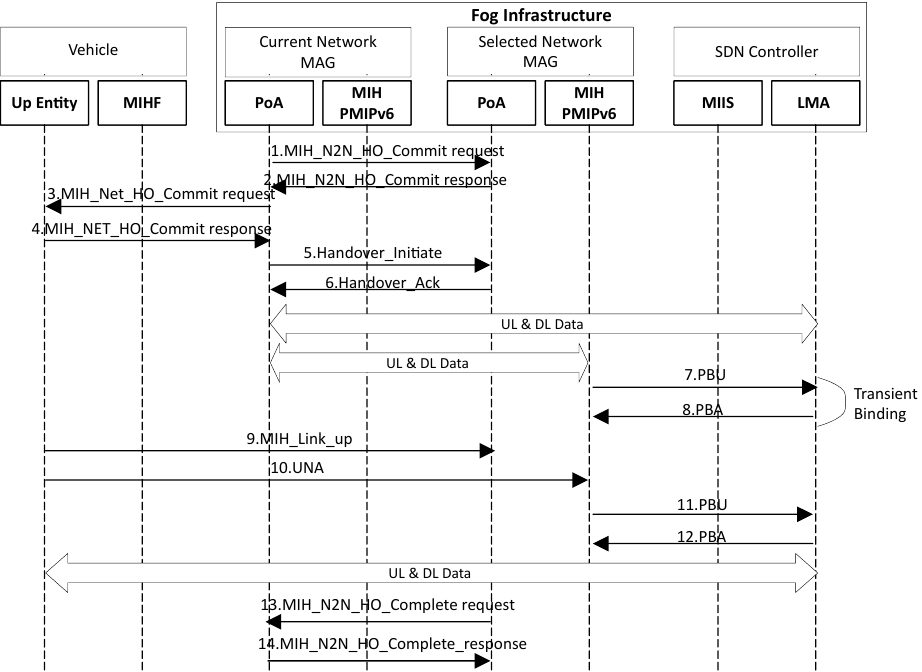
Figure 9. The inter-MAG predictive VHO